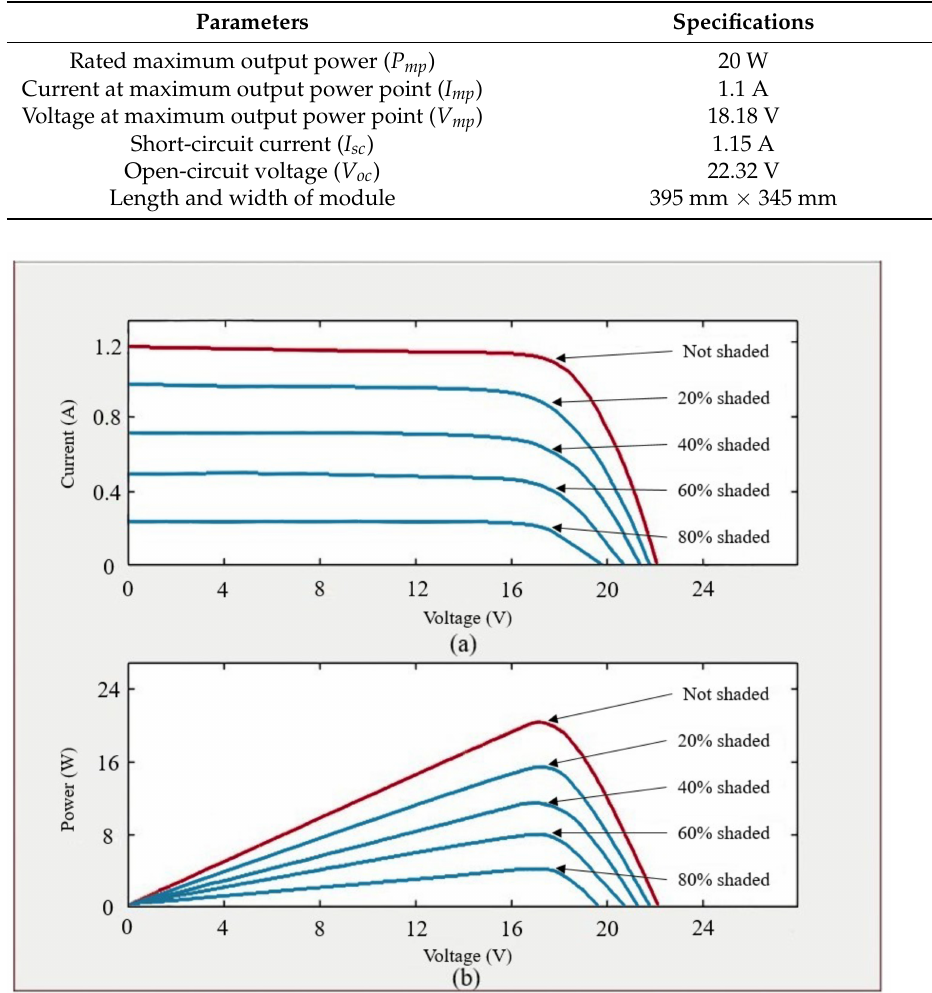
Figure 1. ( a ) I–V and ( b ) P–V characteristic curves of monolithic photovoltaic module under different shading ratios